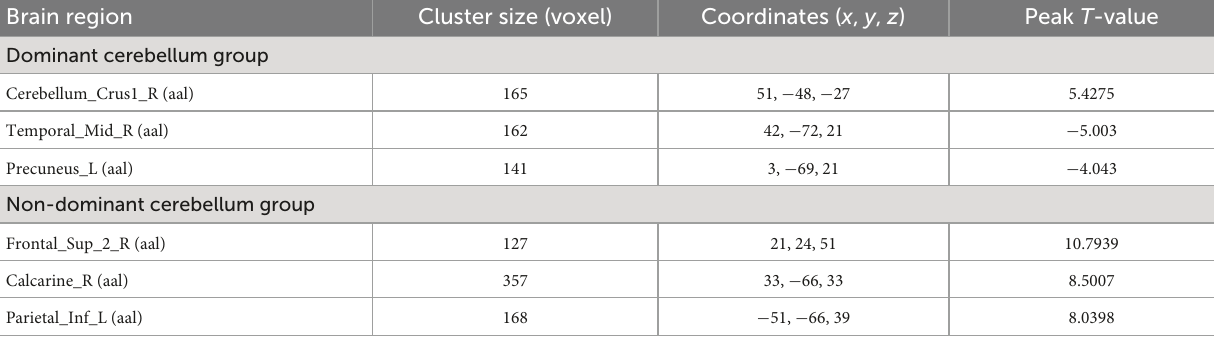
TABLE 2 Brain regions with alteration of fALFF after iTBS in different groups.